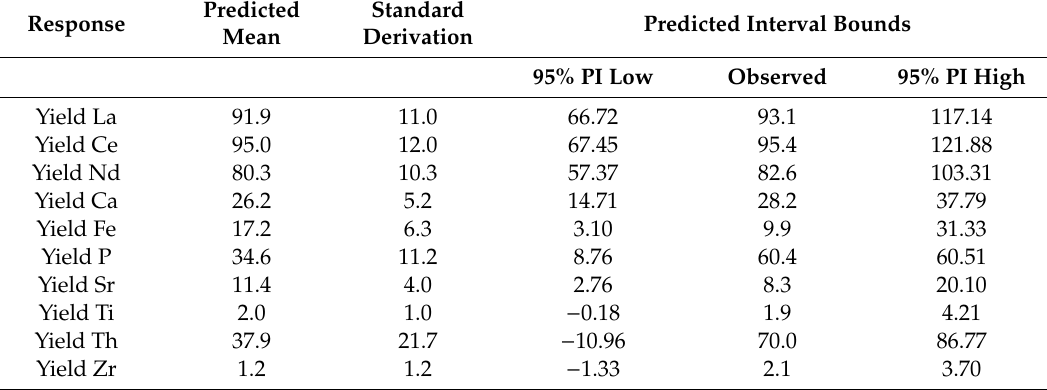
Table 4. Confirmation report for confirmation experiment with the following settings: 6.0 g/g ratio of H 2 SO 4 to REO, 275 °C baking temperature, and 4.3 h baking time.